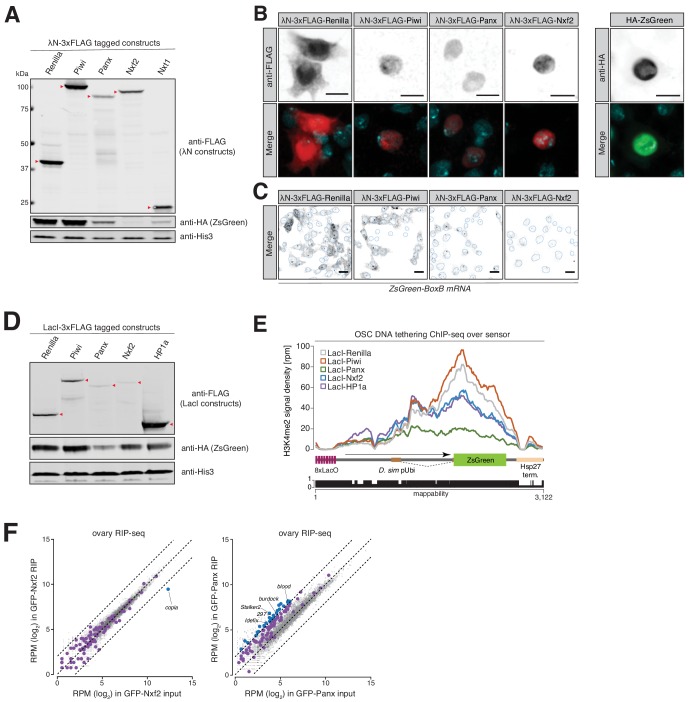
Artificial recruitment of Nxf2 to RNA or DNA results in chromatin silencing.(A) Representative western blot analyses of λN-3xFLAG-fusion proteins, the HA-ZsGreen sensor and a loading control (His3) from lysates of OSCs transfected with the indicated constructs, used for quantification of RNA tethering in Figure 4B. (B) Immunofluorescence staining showing the expression and localization of the indicated λN-3xFLAG-fusion constructs (left, shown in red in the merge) used for tethering assays and the HA-ZsGreen sensor (right, shown in green in the merge) in OSCs alongside DAPI (cyan). Scale bar, 5 µm. (C) Expression and localization of the steady-state RNA levels of the tethering sensor transcript in OSCs transfected with the indicated λN-fusion proteins is shown by RNA-FISH. Scale bar, 10 µm. DAPI was used to draw the nuclear outline. (D) As in (A) but showing representative western blot images of LacI-3xFLAG-fusion constructs used for DNA tethering in Figure 4D. (E) Density profiles of normalized reads from H3K4me2 ChIP-seq experiments mapping to the DNA tethering reporter as indicated in the cartoon below. The mappability of reads is shown below. (F) Scatter plots showing expression levels (reads per million sequenced reads) of genes (in grey) and transposons (in purple) from ovaries in the indicated RIP-seq libraries (left, GFP-Nxf2; right, GFP-Panx). Transposons whose abundance change more than four-fold compared to the input are highlighted in blue.